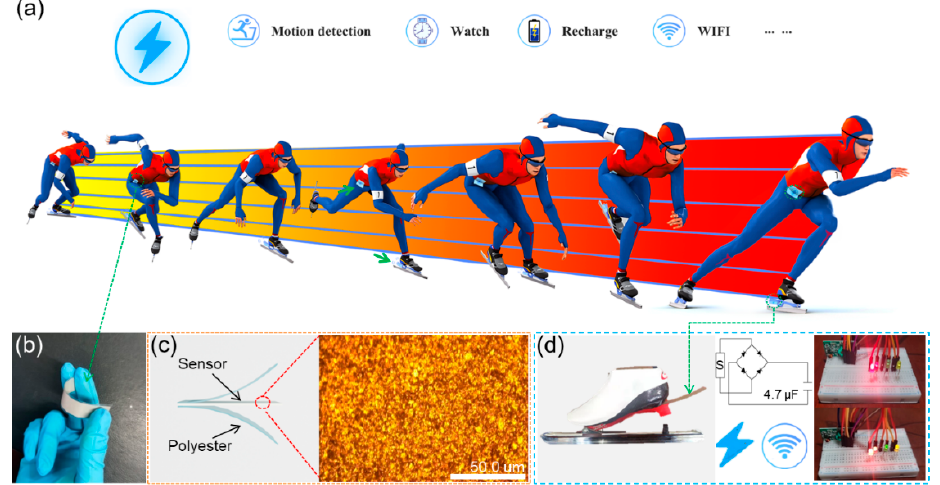
Figure 1. ( a ) The design of the self-powered portable flexible sensor; ( b ) optical image of the sensor; ( c ) structure and micrograph of sensor (inset); ( d ) the sensor attached to the ice skate blade (the insets show the rectifying circuit and the wireless visual panel).